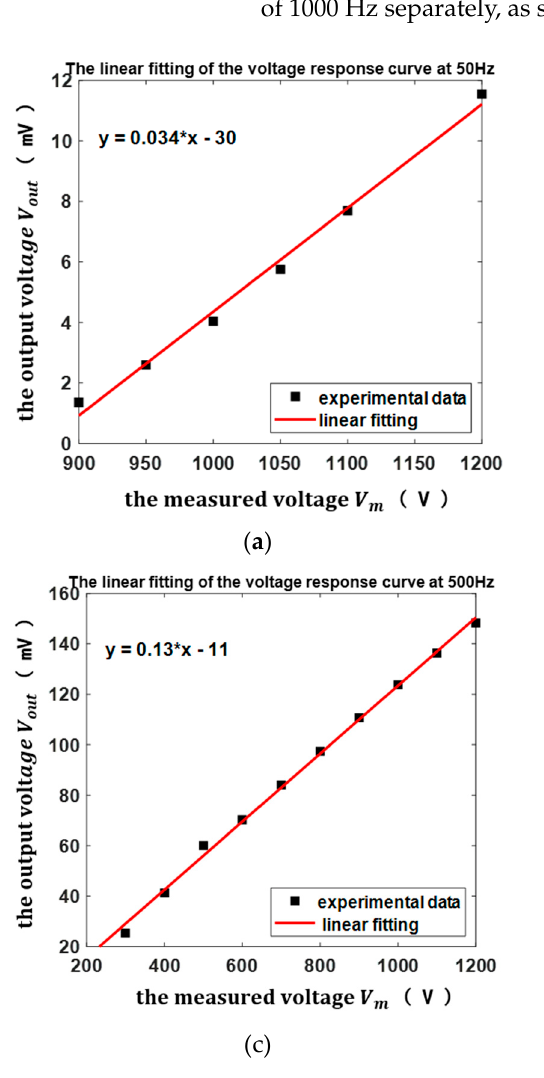
Figure 13. The linear fittings of the sensor voltage response curves at frequencies: ( a ) 50 Hz; ( b ) 200 Hz; ( c ) 500 Hz; ( d ) 1000 Hz.